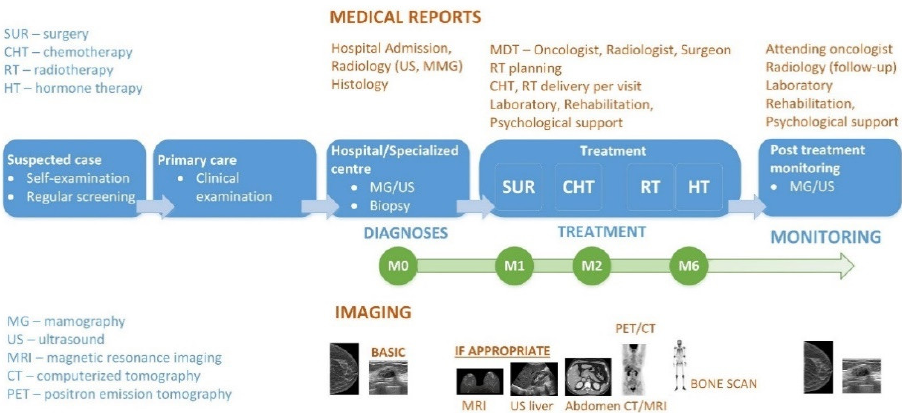
Figure 5. The care pathway in breast cancer with simplified presentation of clinical and imaging data documenting the clinical workflow.